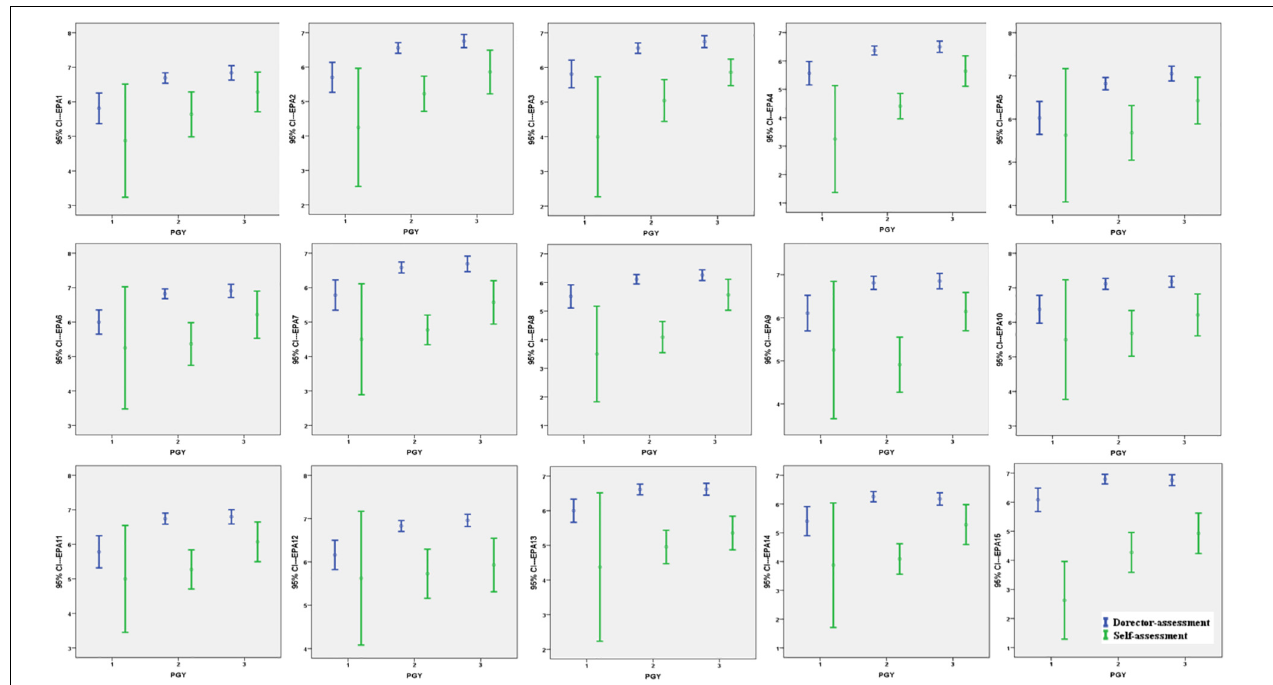
FIGURE 3 | Comparison of director-assessment vs. self-assessment in entrustable professional activities (EPAs) within the same postgraduate year (PGY). The edges of each bar mean the 95% CI of scores of each subgroup in EPAs. The point of each bar in the middle stand for the mean of scores of a certain